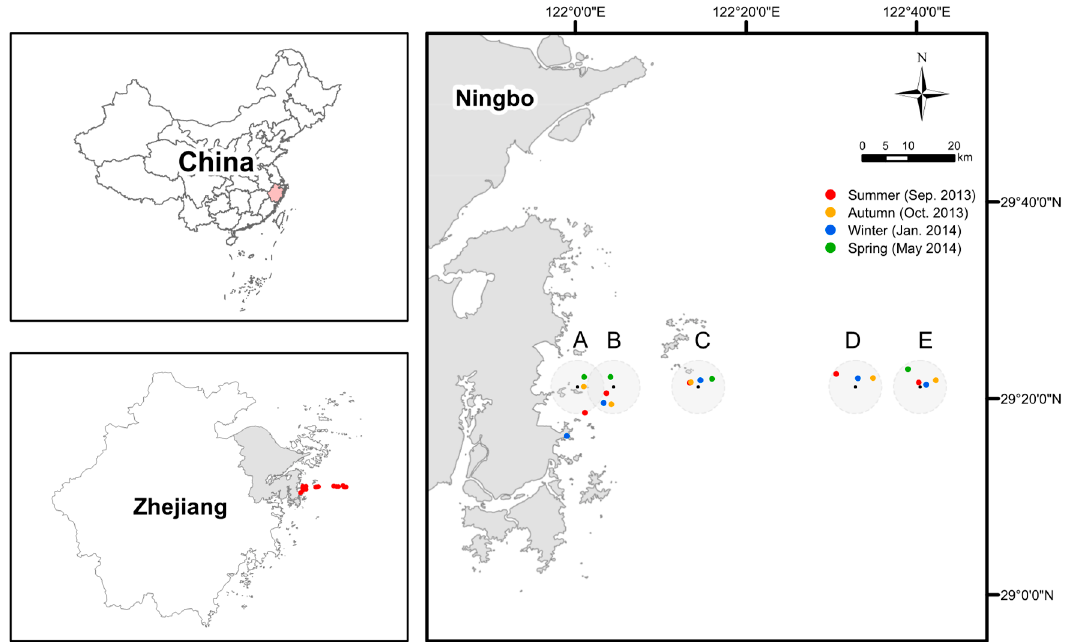
Figure 1. The map of sampling sites (with IDs as A, B, C, D, and E) and specific stations in each season. Due to the weather and sea conditions, the geographic coordinates of representative stations of each site actually being sampled are somewhat different in four seasons but within a radius of 5 km (except the one for site A in the winter, target site missed because of misreading the coordinates on board).